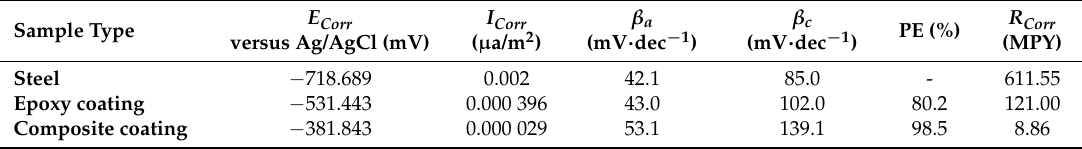
Table 2. Corrosion potential ( E corr ), corrosion current density ( I corr ), corrosion protection efficiency (PE), and corrosion rate ( R Corr ) derived from Tafel plot